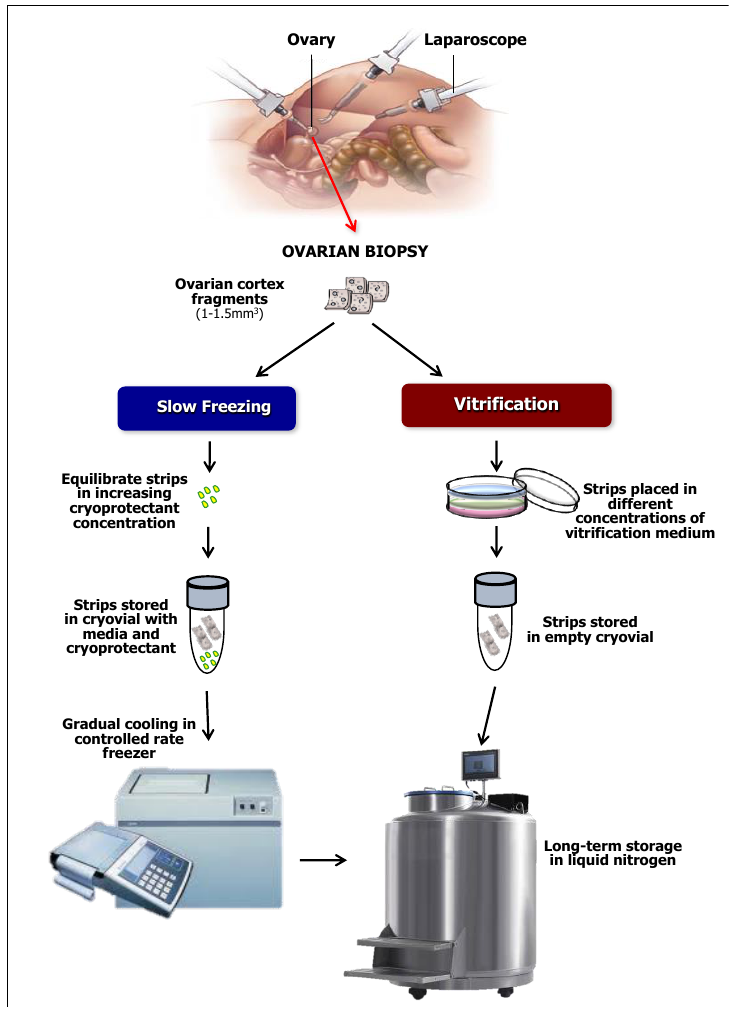
Figure 1. Schematic representation of two procedures of ovarian cortex cryopreservation by laparo- scopic retrieval.